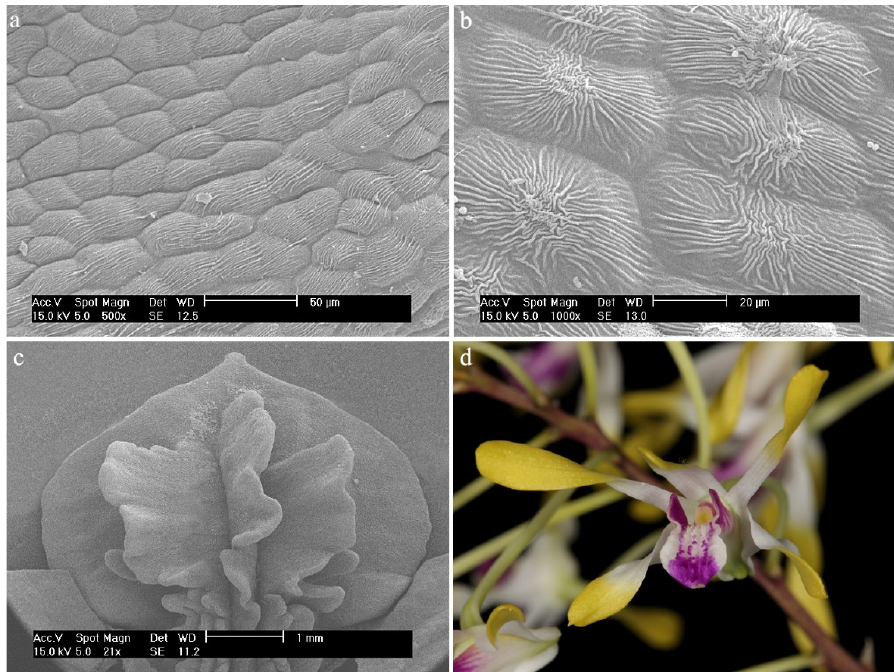
Figure 25. Dendrobium canaliculatum R.Br.: ( a , b ) the mesochile part of the labellum; ( c ) the epichile part of the labellum; ( d ) flower (photo by John Varigos). part of the labellum; ( d ) flower (photo by John